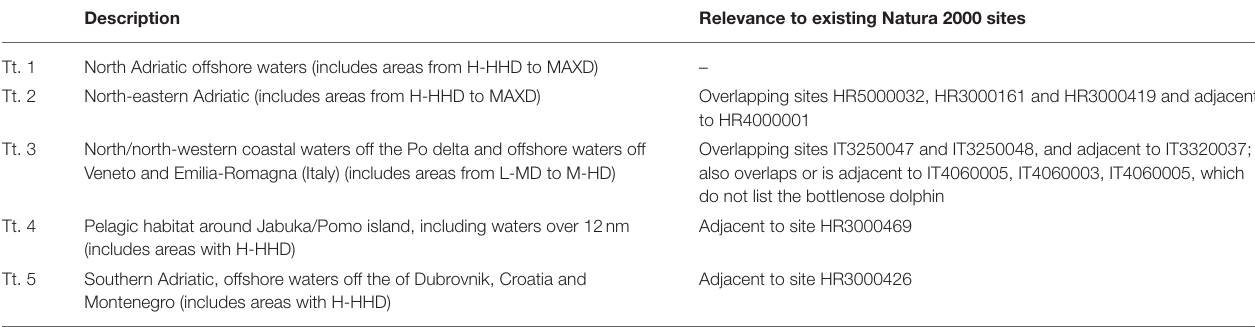
TABLE 3 | Key areas for bottlenose dolphins in the Adriatic Sea based upon the combined 2010 and 2013 datasets (see Figure 1 ).